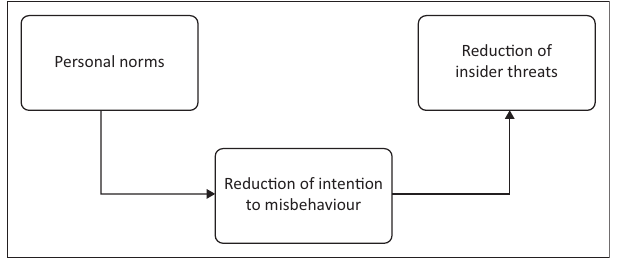
FIGURE 4: Model on the reduction of cybersecurity insider threats